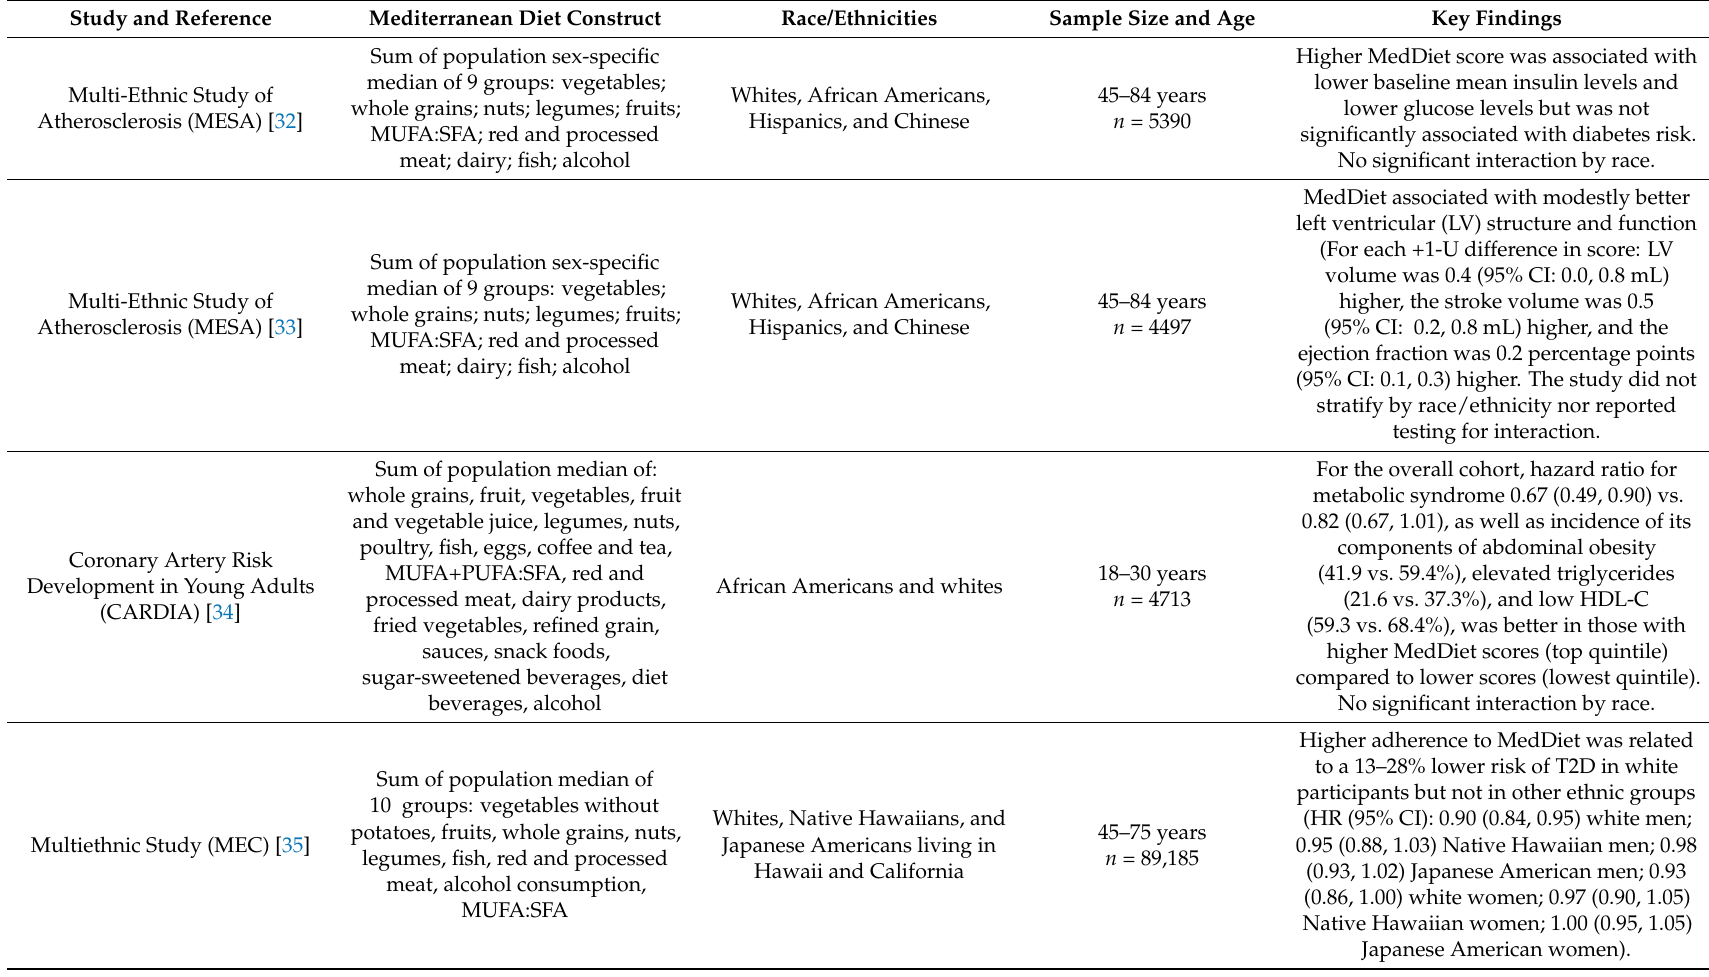
Table 1. Summary of population-based studies assessing association of Mediterranean diet and cardiometabolic outcomes in minority racial/ethnic populations in the